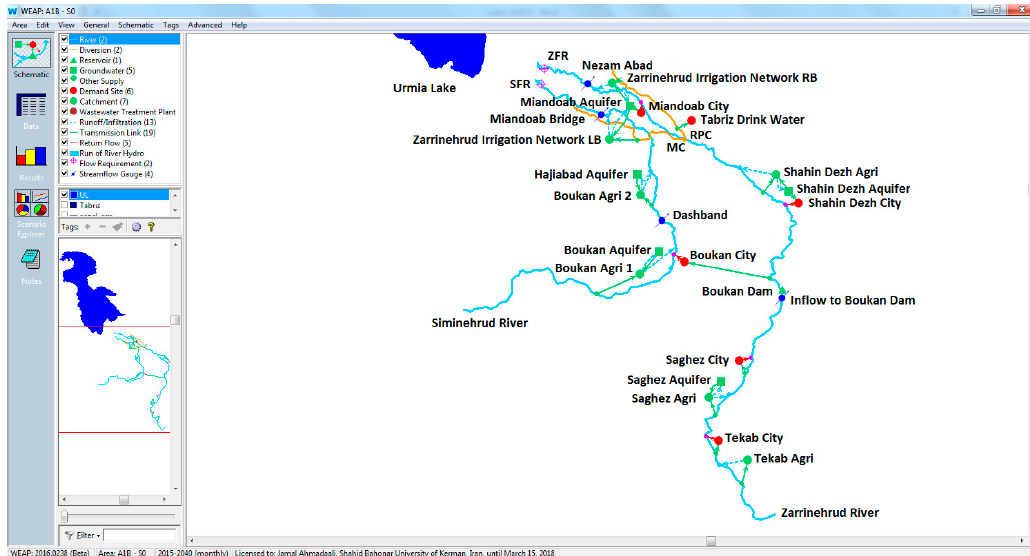
Figure 3. Schematic of WEAP model for Zarrinehrud and Siminehrud River basins.